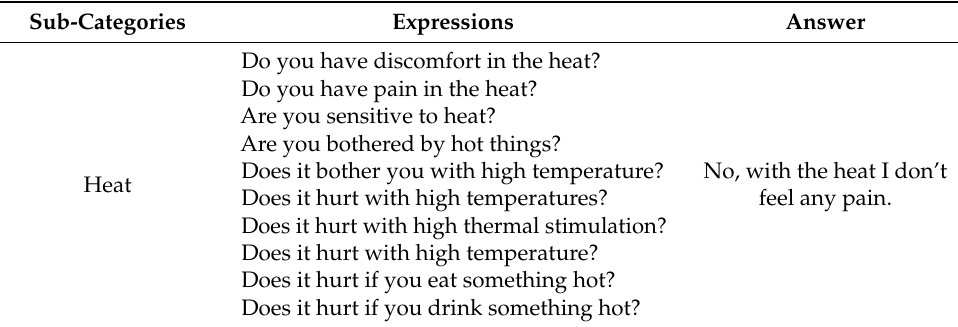
Table 1. Example of the expressions for a question about Julia’s response if heat is applied with a corresponding answer.